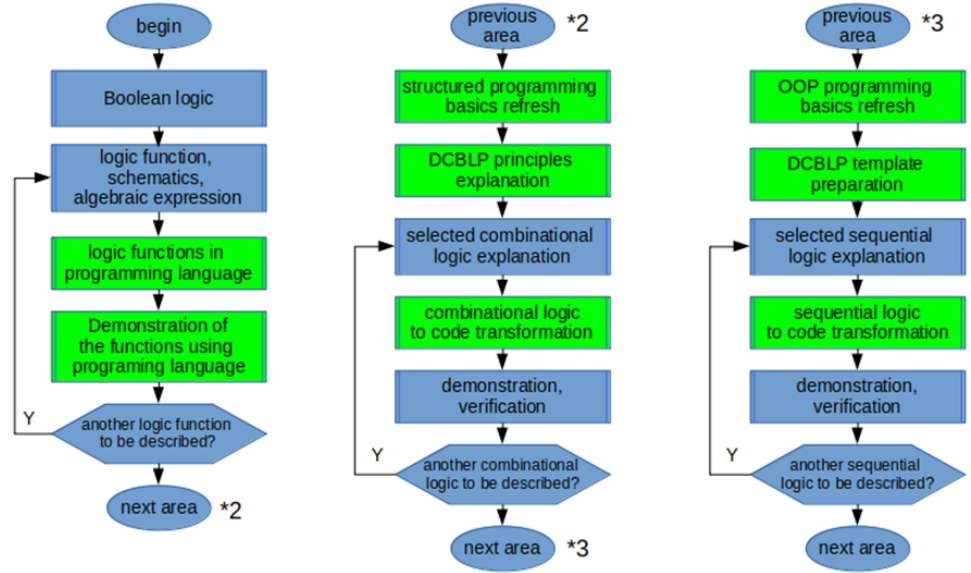
Figure 5. Flow-charts for the training areas enhanced by DCBLP. * means sequence how the particular areas